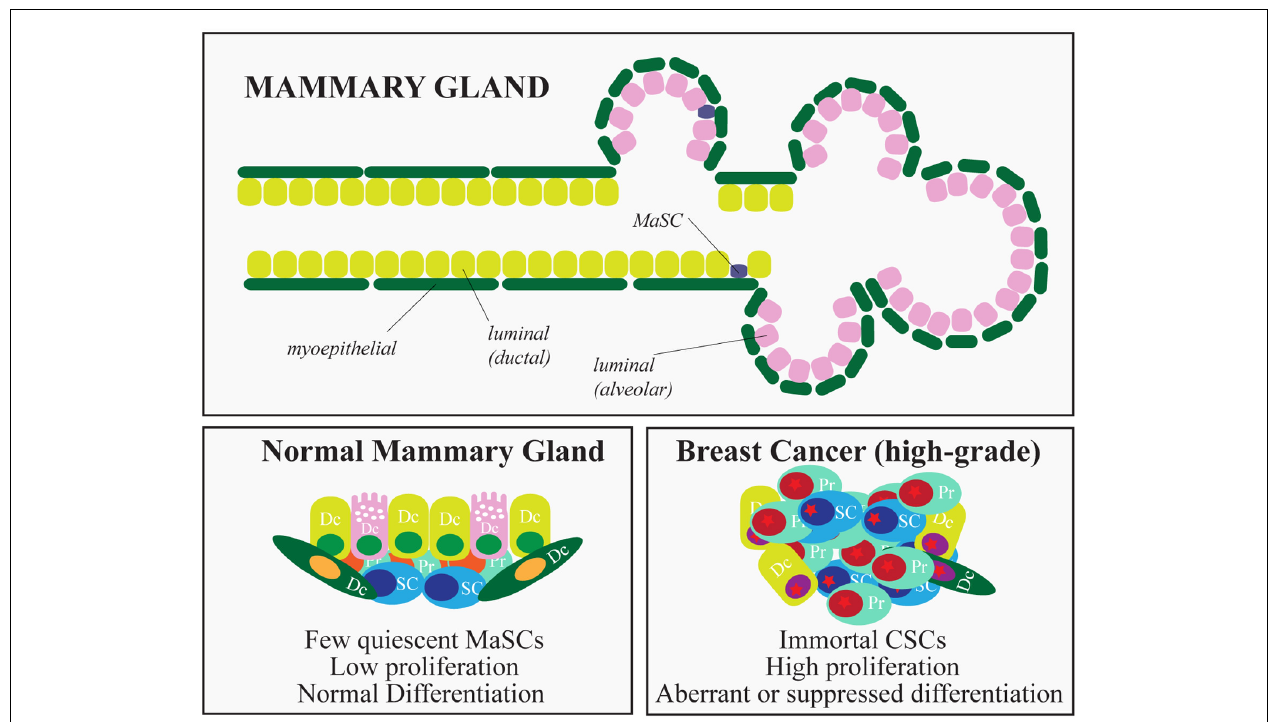
FIGURE 3 | Hierarchical organization of the mammary gland and breast cancer subtypes. The figure depicts the epithelial components of the mammary gland. In the lower part, the characteristics of normal and cancer stem cells are summarized. (SC, stem cells; PC, progenitors; DC, differentiated